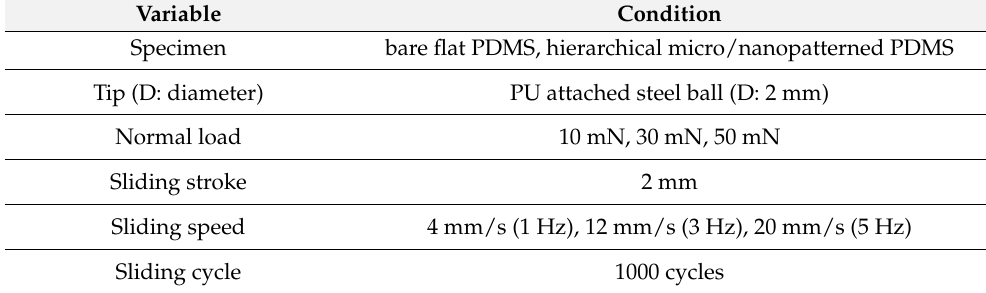
Table 1. Experimental